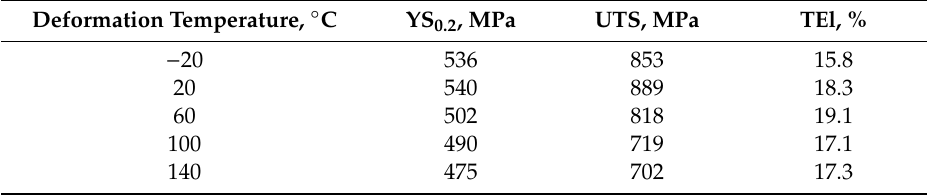
Table 2. Mechanical properties of steel deformed at various